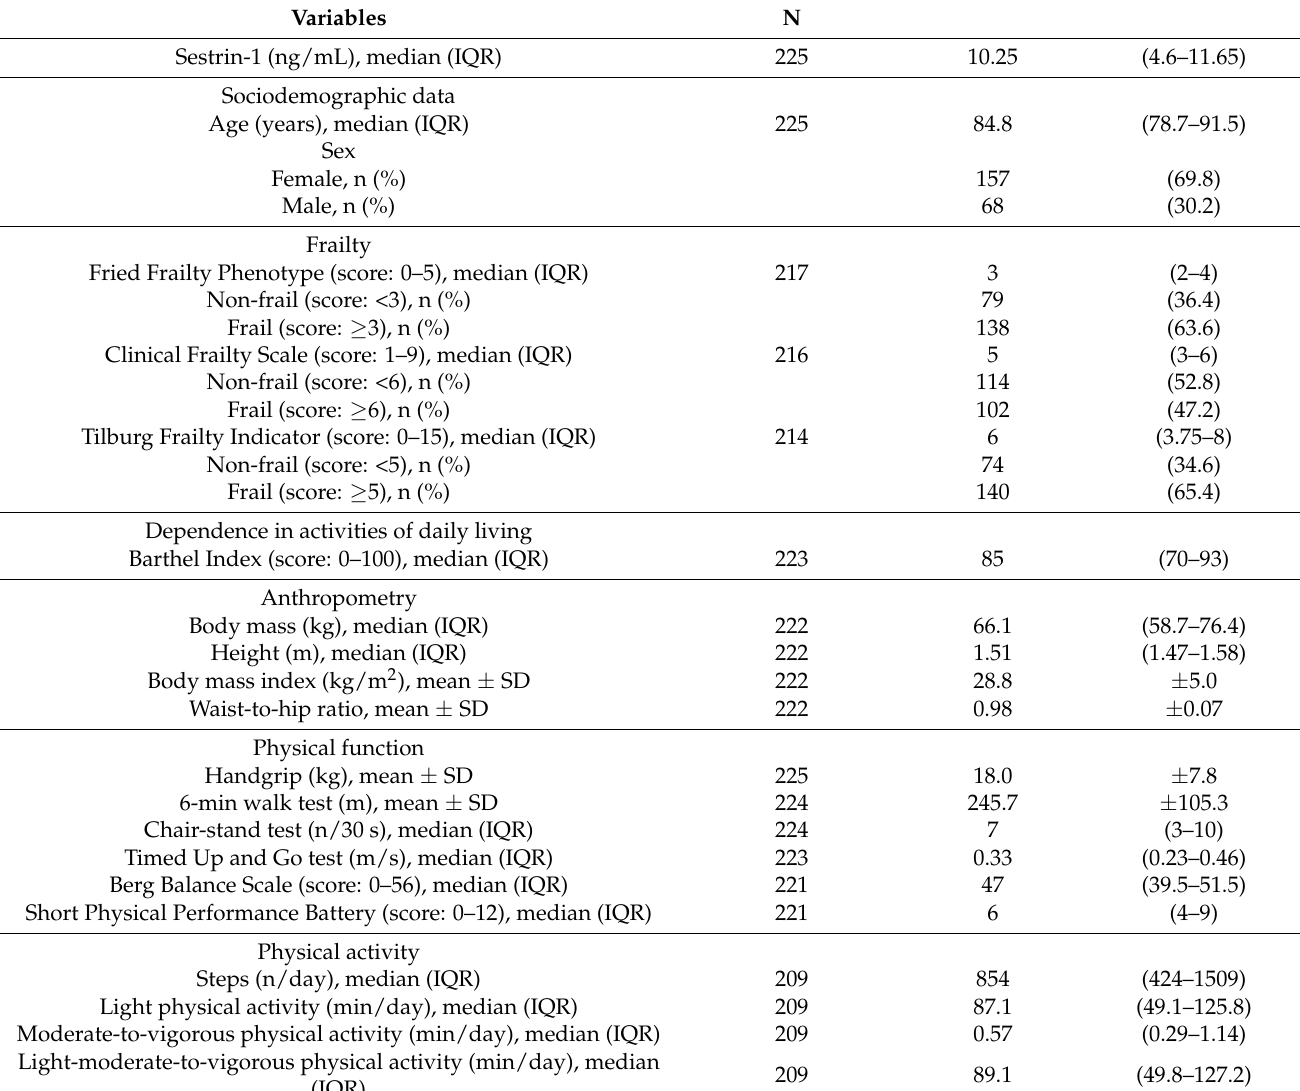
Table 2. Descriptive data of the analyzed variables. Quantitative non-normal variables and ordinal variables are expressed as the median and the interquartile range (IQR). Categorical variables are shown as n and %. Quantitative normal variables are shown as the mean ± the standard deviation (SD).